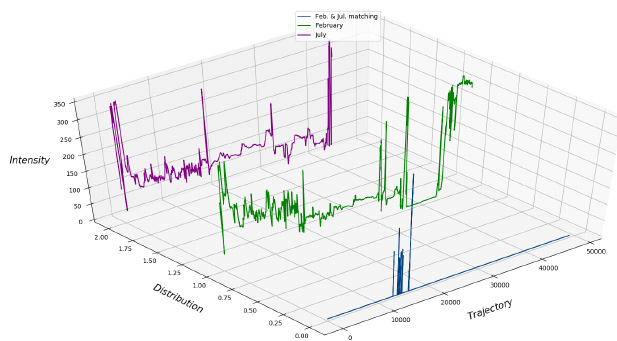
Figure 8. Unique light segments between Γ SL=30 and ρ